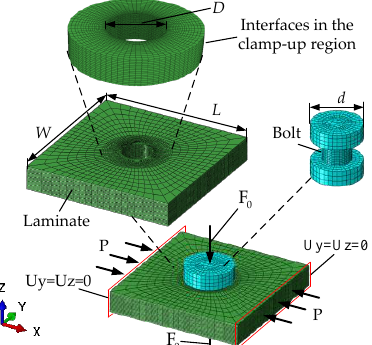
Figure 5. Finite element mesh and modeling strategy for a filled hole compression (FHC) specimen, and showing boundary conditions.